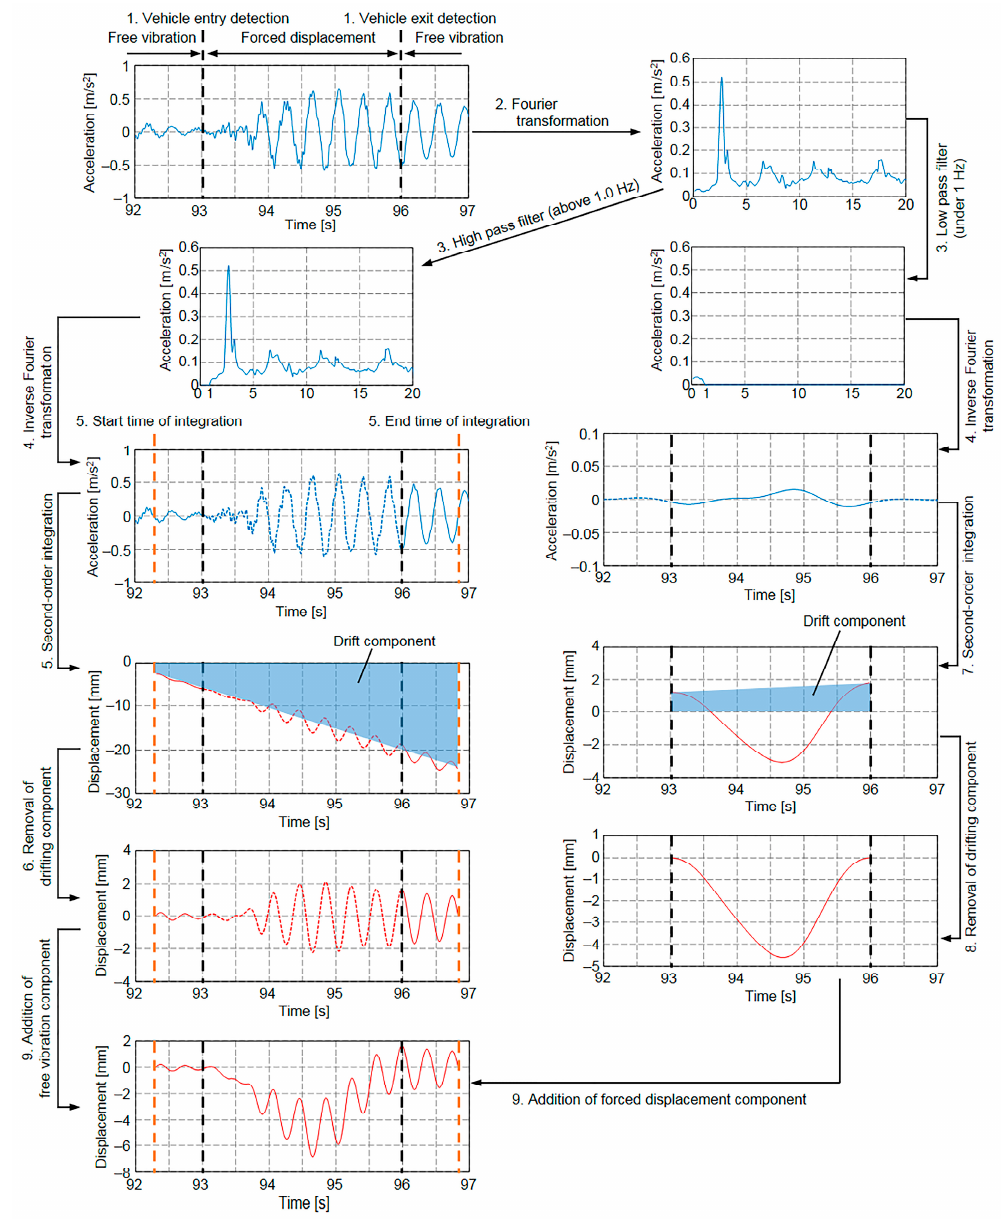
Figure 9. Application of proposed free vibration separation method of determining bridge Application of proposed free vibration separation method of determining displacement. bridge